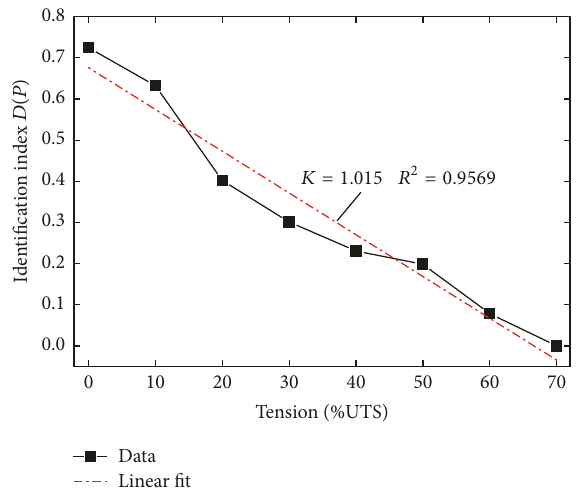
Figure 6: Proposed identification index and